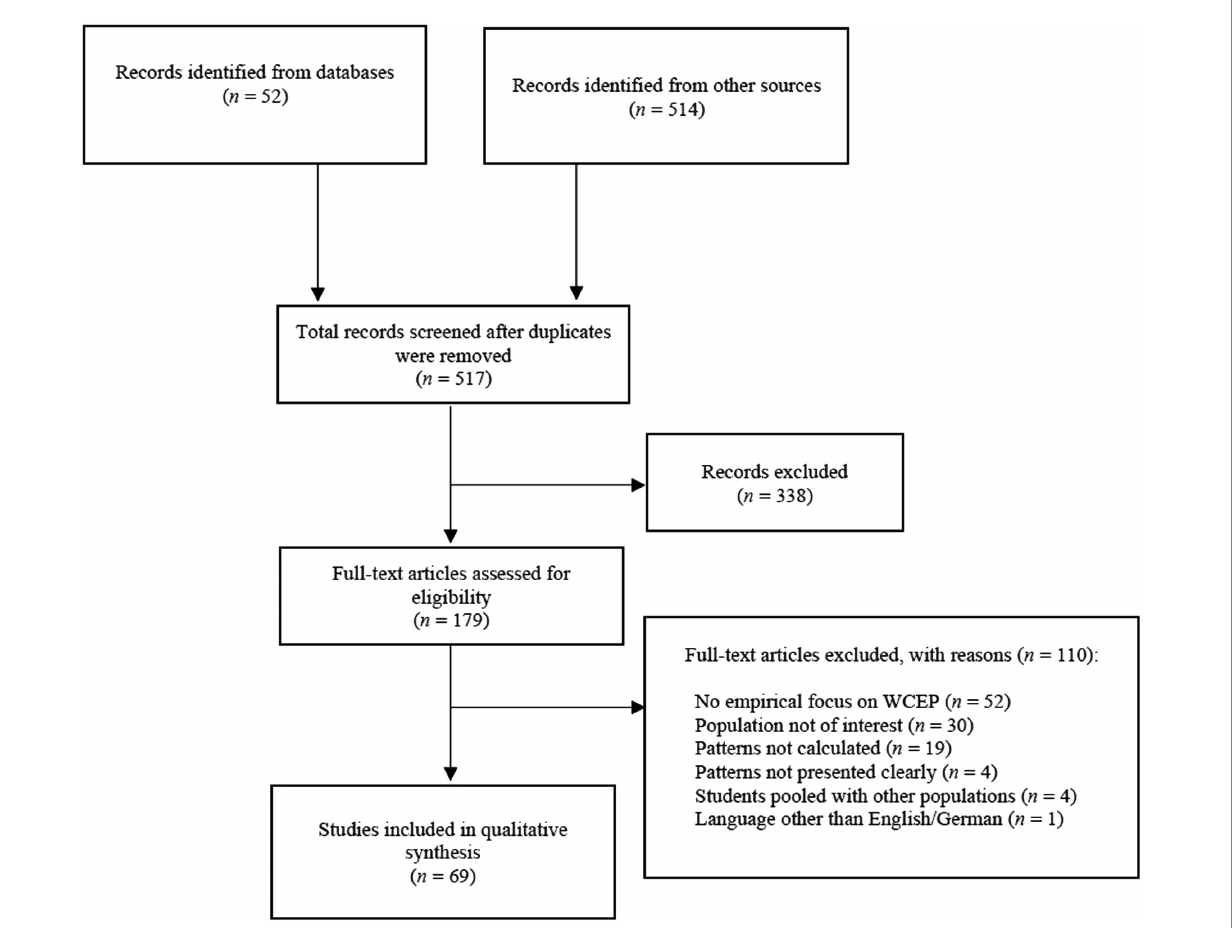
FIGURE 1 A flowchart of the search strategy. Flowchart adapted from PRISMA 2020 flow diagram for new systematic reviews which included searches of databases, registers and other sources available at